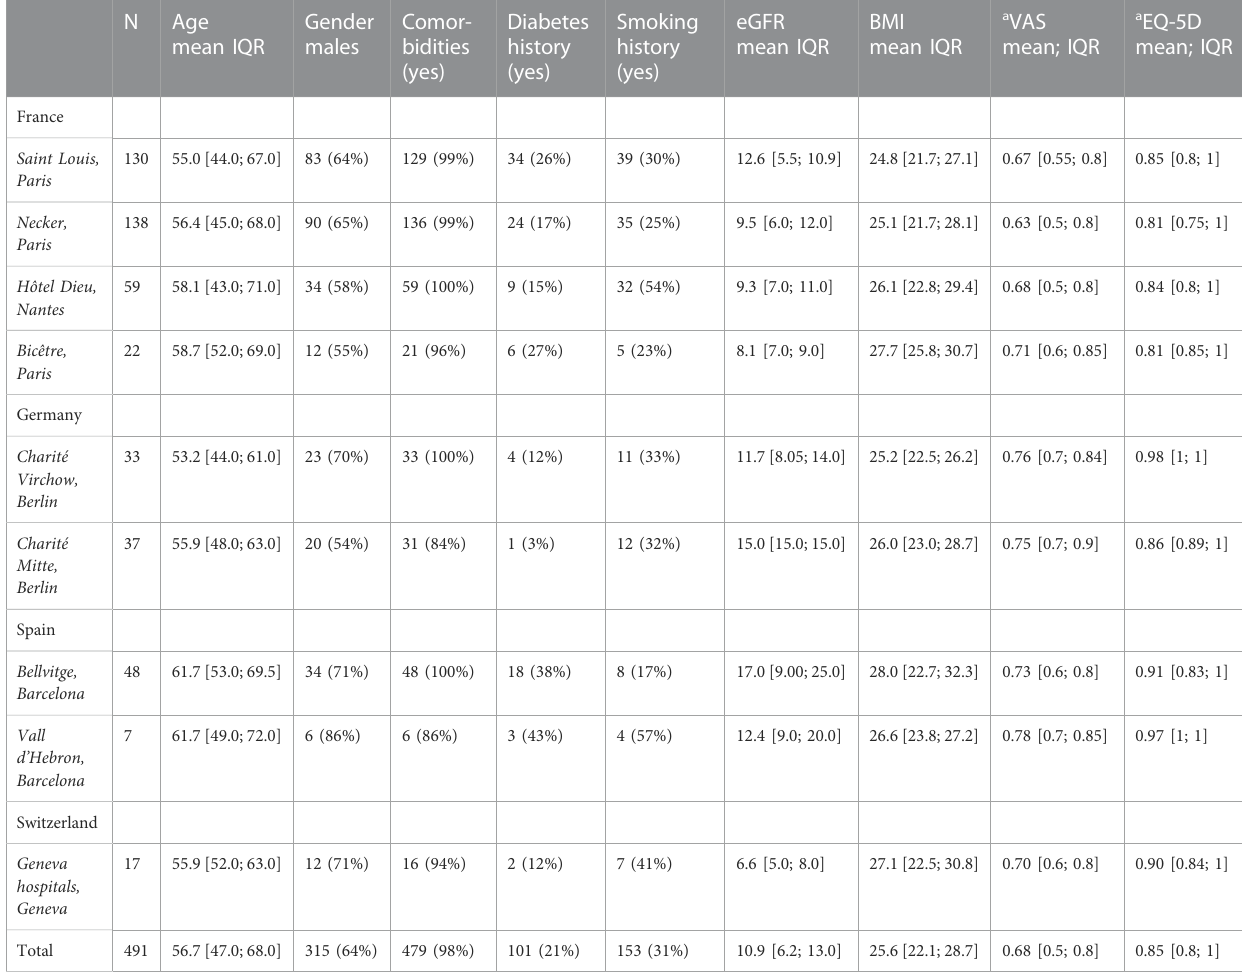
TABLE 1 Descriptive characteristics of the patient sample at